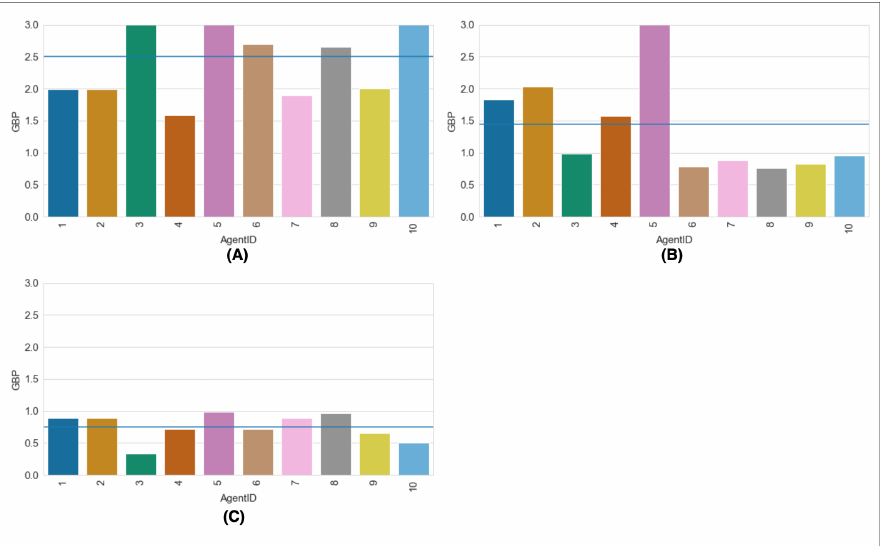
Figure 10. The total sum of petrol costs (GBP) for each ICEV, model conditions 1 to 3. Where ( A ): 10 vehicles, 10 non-adherence, ( B ): 10 vehicles, 5 non-adherence and ( C ): 10 vehicles, 0